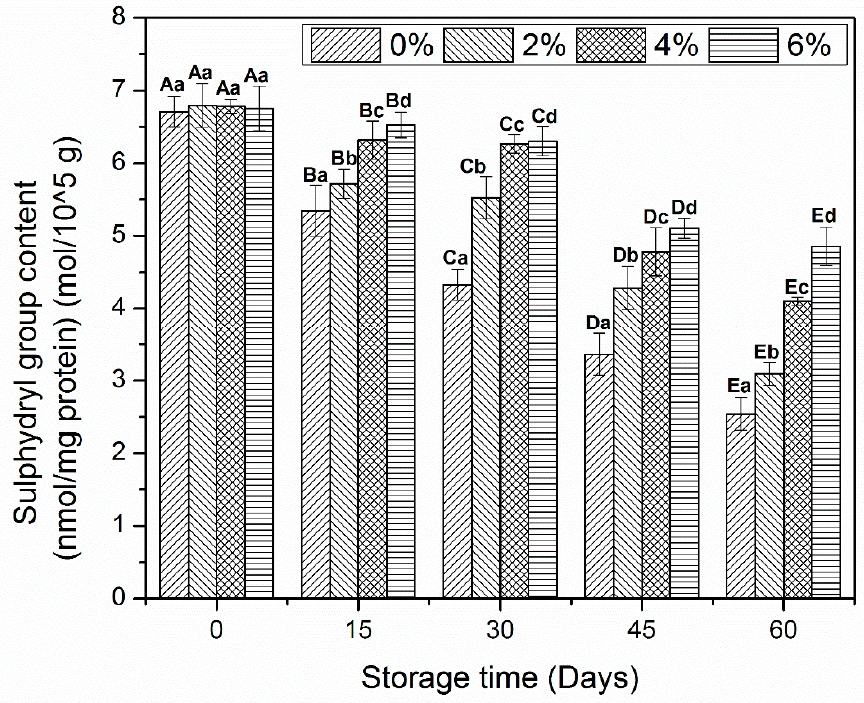
Figure 3. Sulfhydryl contents myofibrillar protein treated with different concentrations of OVA-KC during 60 days of frozen storage at − 18 °C. Capital letters (A–E) refers to the significant differences in similar treatments within the different storage times ( p < 0.05). Lowercase letters (a–d) refers to the significant difference in the same frozen storage period of different concentrations ( p < 0.05).